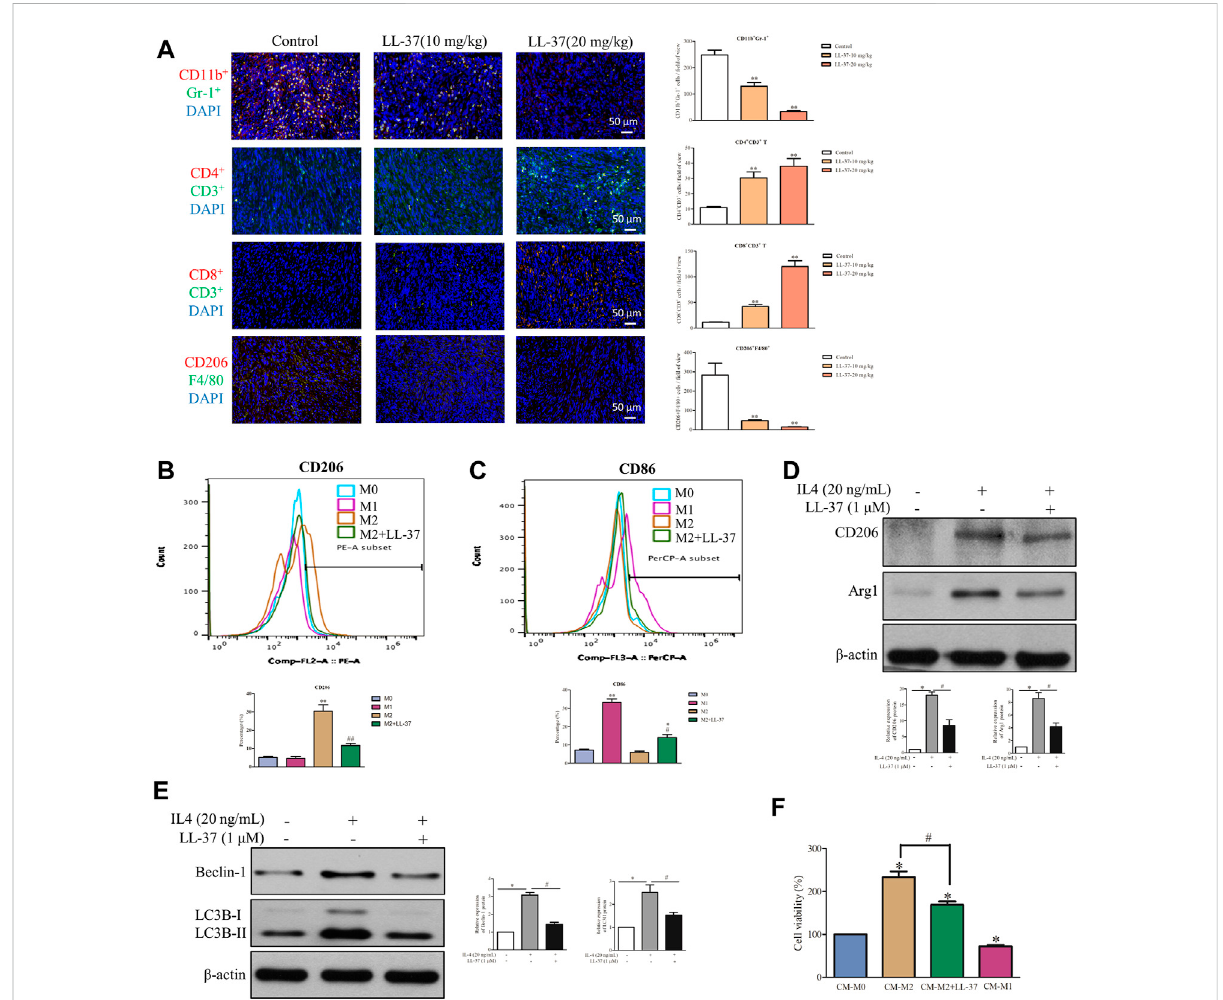
FIGURE 6 LL-37 reprogrammed the immune cells in the tumor microenvironment. (A) A dual-immuno fl uorescence analysis was used to identify the myeloid-derived suppressor cells (MDSCs), CD4 + T cells, CD8 + T cells and M2 macrophages in the tumor tissues (scale bar = 50 μ M, 400× magni fi cation). The positively stained cells were quanti fi ed using Image-pro plus 6.0. ** p < 0.01 vs . Control group. The effect of LL-37 on the polarizationofmacrophageswasdeterminedusinga fl owcytometer.F4/80isthecommonmarkerofmacrophagescell. (B) CD206isaspeci fi c surfacemarkerfor M2macrophages. (C) CD86 isaspeci fi csurfacemarkerfor M1macrophages.The percentage ofCD206 and CD86expression on F4/80 macrophages werequanti fi ed. * p < 0.05, ** p < 0.01 vs. M0 group, # p < 0.05, ## p < 0.01 vs . M2 group. The effect ofLL-37on the expression of the M2 macrophage markers (D) and autophagy markers (E) measured using western blot in RAW264.7 cells treated with IL-4. Non-arbitrary band density data relative to those of the housekeeping protein ß -actin are presented as mean ± SD, * p < 0.01 for IL-4 treatment vs . control, # p < 0.01 for LL-37 + IL-4 treatment vs . IL-4 treatment. (F) Cell viability of PAN02 cultured with conditioned medium from M0 macrophages (CM-M0), M1 macrophages (CM-M1), M2 macrophages (CM-M2) and M2 macrophages + LL-37 (CM-M2+LL-37). CM-M1 is positive control. Data are presented as the means ± SD of three independent experiments each conducted in triplicate. * p < 0.01 for CM-M2 vs . CM-M0, # p < 0.01 for CM- M2+LL-37 vs .